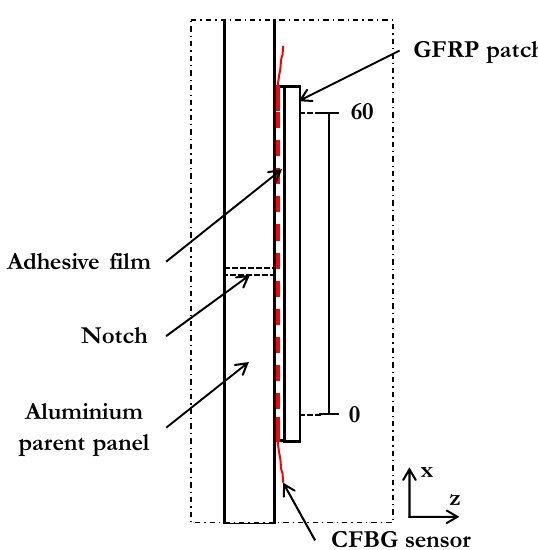
Figure 5. Schematic of the edge view of the specimen along the sensor line (not to scale).